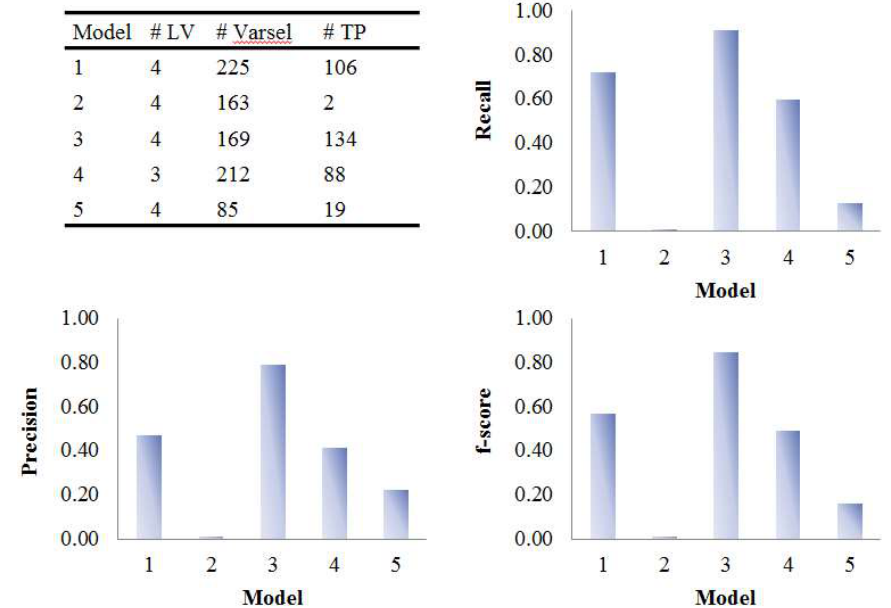
Figure 8. Evaluation of the variable selection performance of five PLS models on onion study data. Recall, precision and F 1 -score were calculated based on the variable selection confusion matrix. # LV, number of latent variables; # Varsel, number of selected variables; # TP, number of true positives.